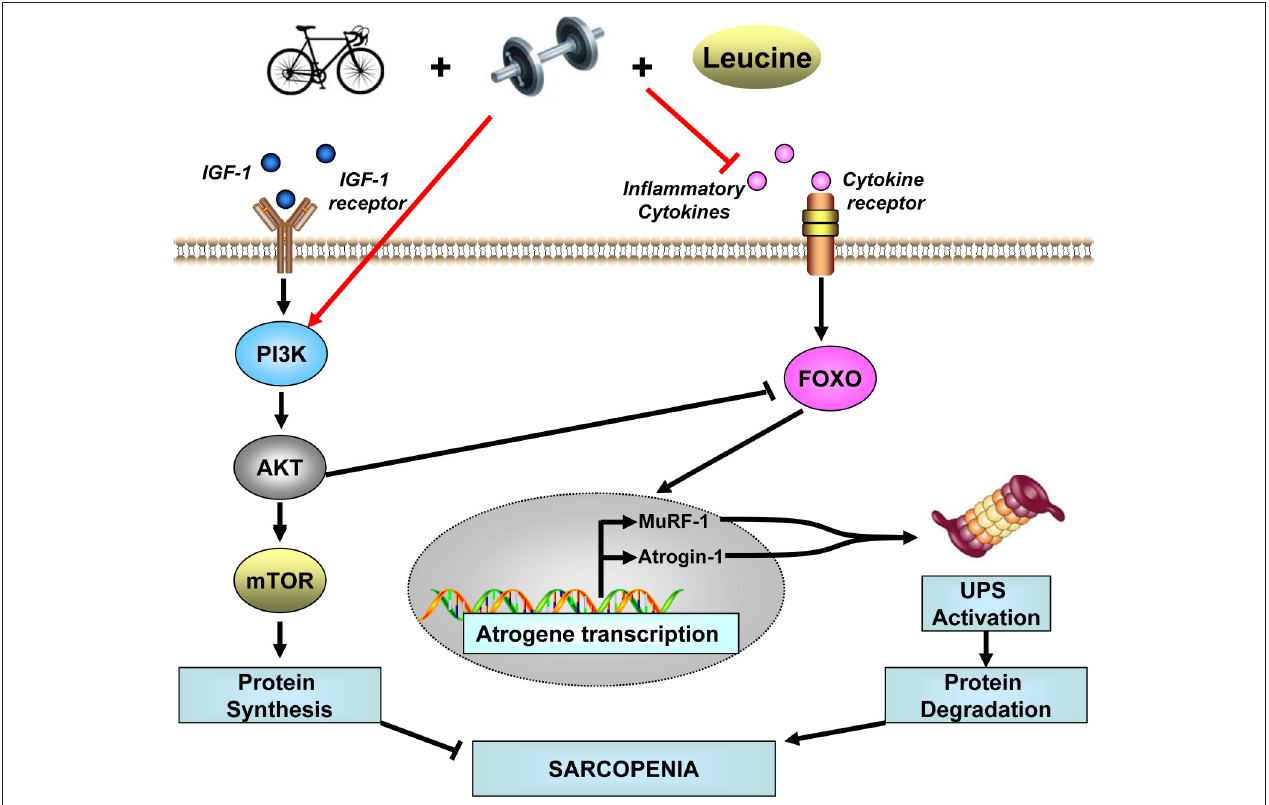
FIGURE 2 | Possible effects of concurrent resistance and aerobic exercise and leucine supplementation to molecular mechanism that may accelerate MPS and decelerate MPB. IGF-1, Insulin-like growth factor 1; PI3K, phosphatidylinositol 3 kinase; Akt, serine/threonine protein kinase; mTOR, mammalian target of rapamycin; FOXO, Forkhead box protein O; MuRF-1, muscle ring finger-1; Atrogin-1, Muscle Atrophy F-box; UPS, ubiquitin-proteasome